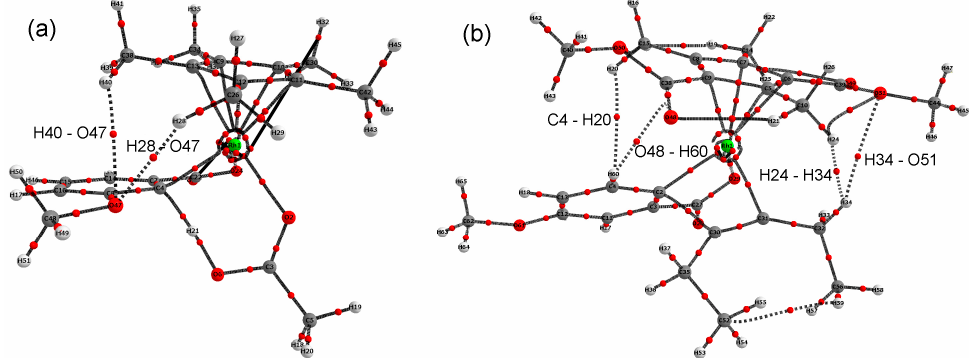
Figure 8. Theoretical molecular graphs of TS0_Cp* ( a ) and TS’1_H_CpE ( b ). Calculated parameters of the electron density distribution at the selected bond critical points are as follows: H40-O47 ( ρ (r) = 0.008 e bohr –3 , ∇ 2 ρ (r) = 0.035 e bohr –3 , H (r) = 0.002 a.u.); H28-O47 ( ρ (r) = 0.007 e bohr –3 , ∇ 2 ρ (r) = 0.030 e bohr –3 , H (r) = 0.002 a.u.); H34-O51 ( ρ (r) = 0.005 e bohr –3 , ∇ 2 ρ (r) = 0.018 e bohr –3 , H (r) = 0.001 a.u.).